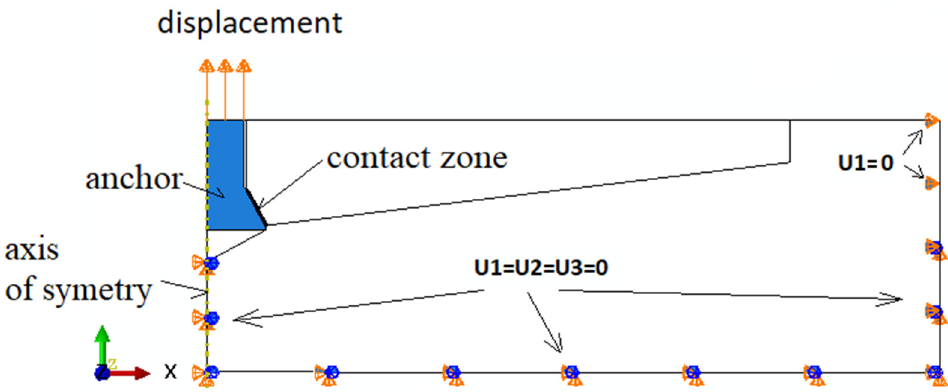
Figure 6. The scheme of boundary conditions assumed in the model.